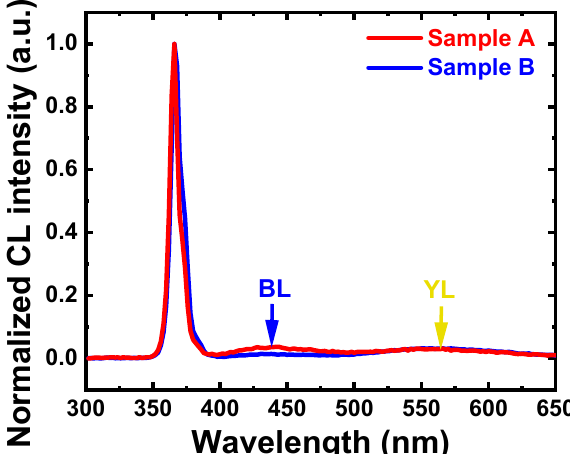
Figure 3. Normalized CL spectra of samples A and B.